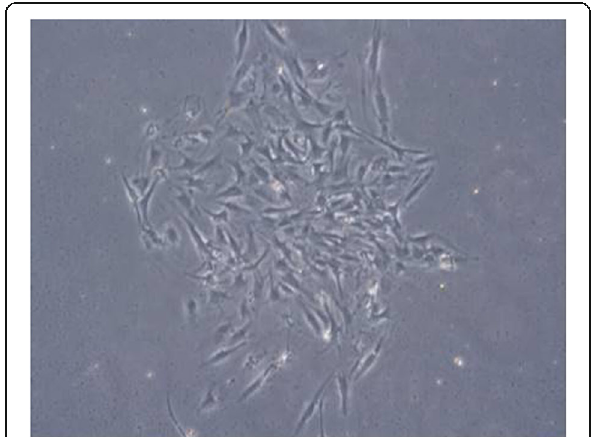
Fig. 2 Photomicrograph of colony formation of the DPSCs illustrating an increase in the number of stem cells and colony formation (magnification × 100)